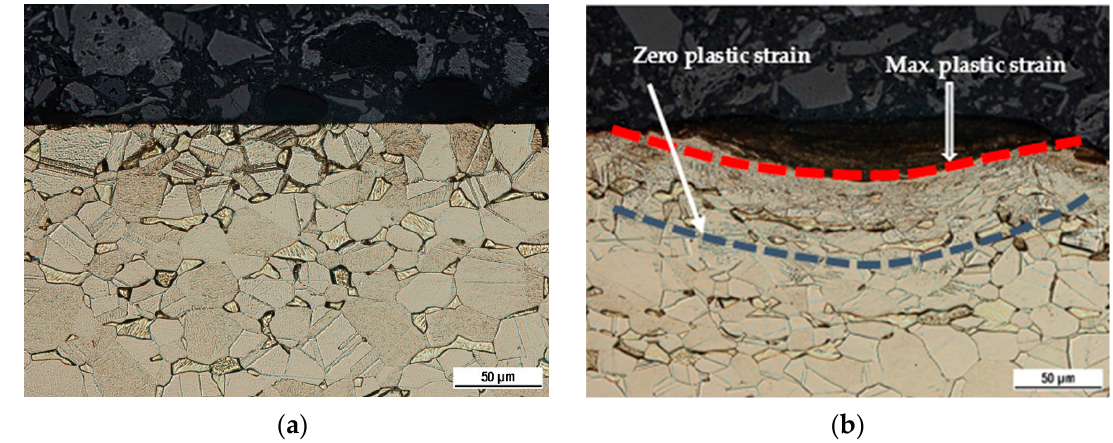
Figure 2. Cross-sectional metallographs of surfaces. ( a ) Unhardened surface; ( b ) at 1500 rpm and 6 mm min − 1